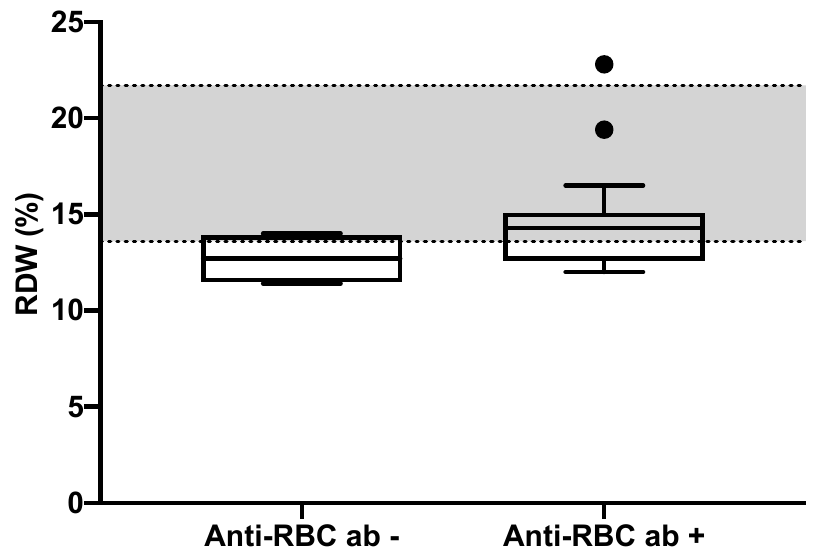
Figure 1. Box and whiskers of RDW (%) representation in IBD dogs with anti-RBC antibodies negative or positive (median 12.7 vs. 14.3%, p = 0.03). The boxes represent the 25th and 75th percentile, the line in the boxes is the median RDW value and the whiskers are minimum and maximum values. The two points in the group of anti-RBC antibodies positive are outliers. The gray band represents the RDW reference interval. Table 1. Descriptive statistics of erythrocyte parameters in the study population.